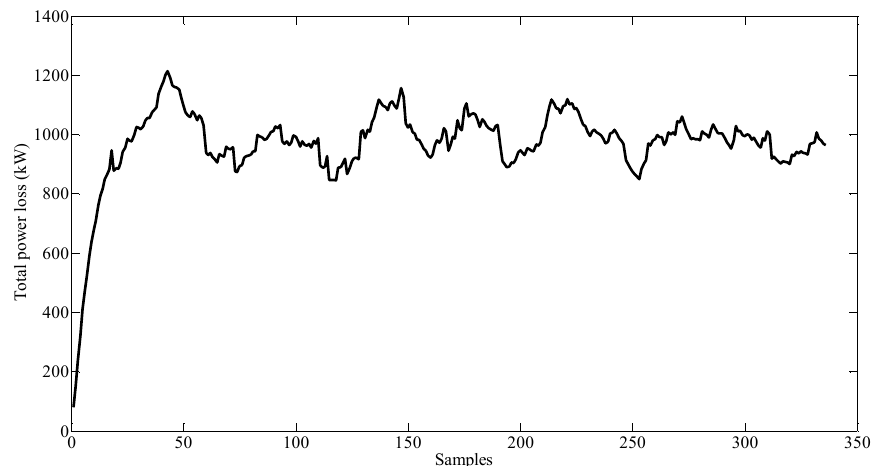
Figure 9. Optimal power loss when calculating PEV demand by average queuing parameters.